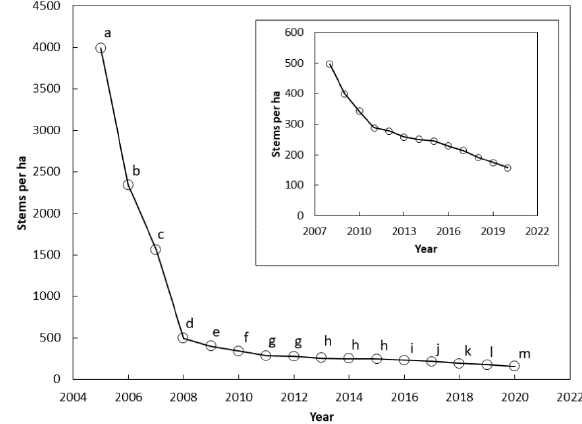
Figure 2. The number of Cycas micronesica stems per ha (all size categories) among 12 Guam habitats from 2005 until 2020. The inset shows results from 2008 until 2020 with smaller vertical axis range. Markers with the same letter are not different according to Bonferroni comparisons.